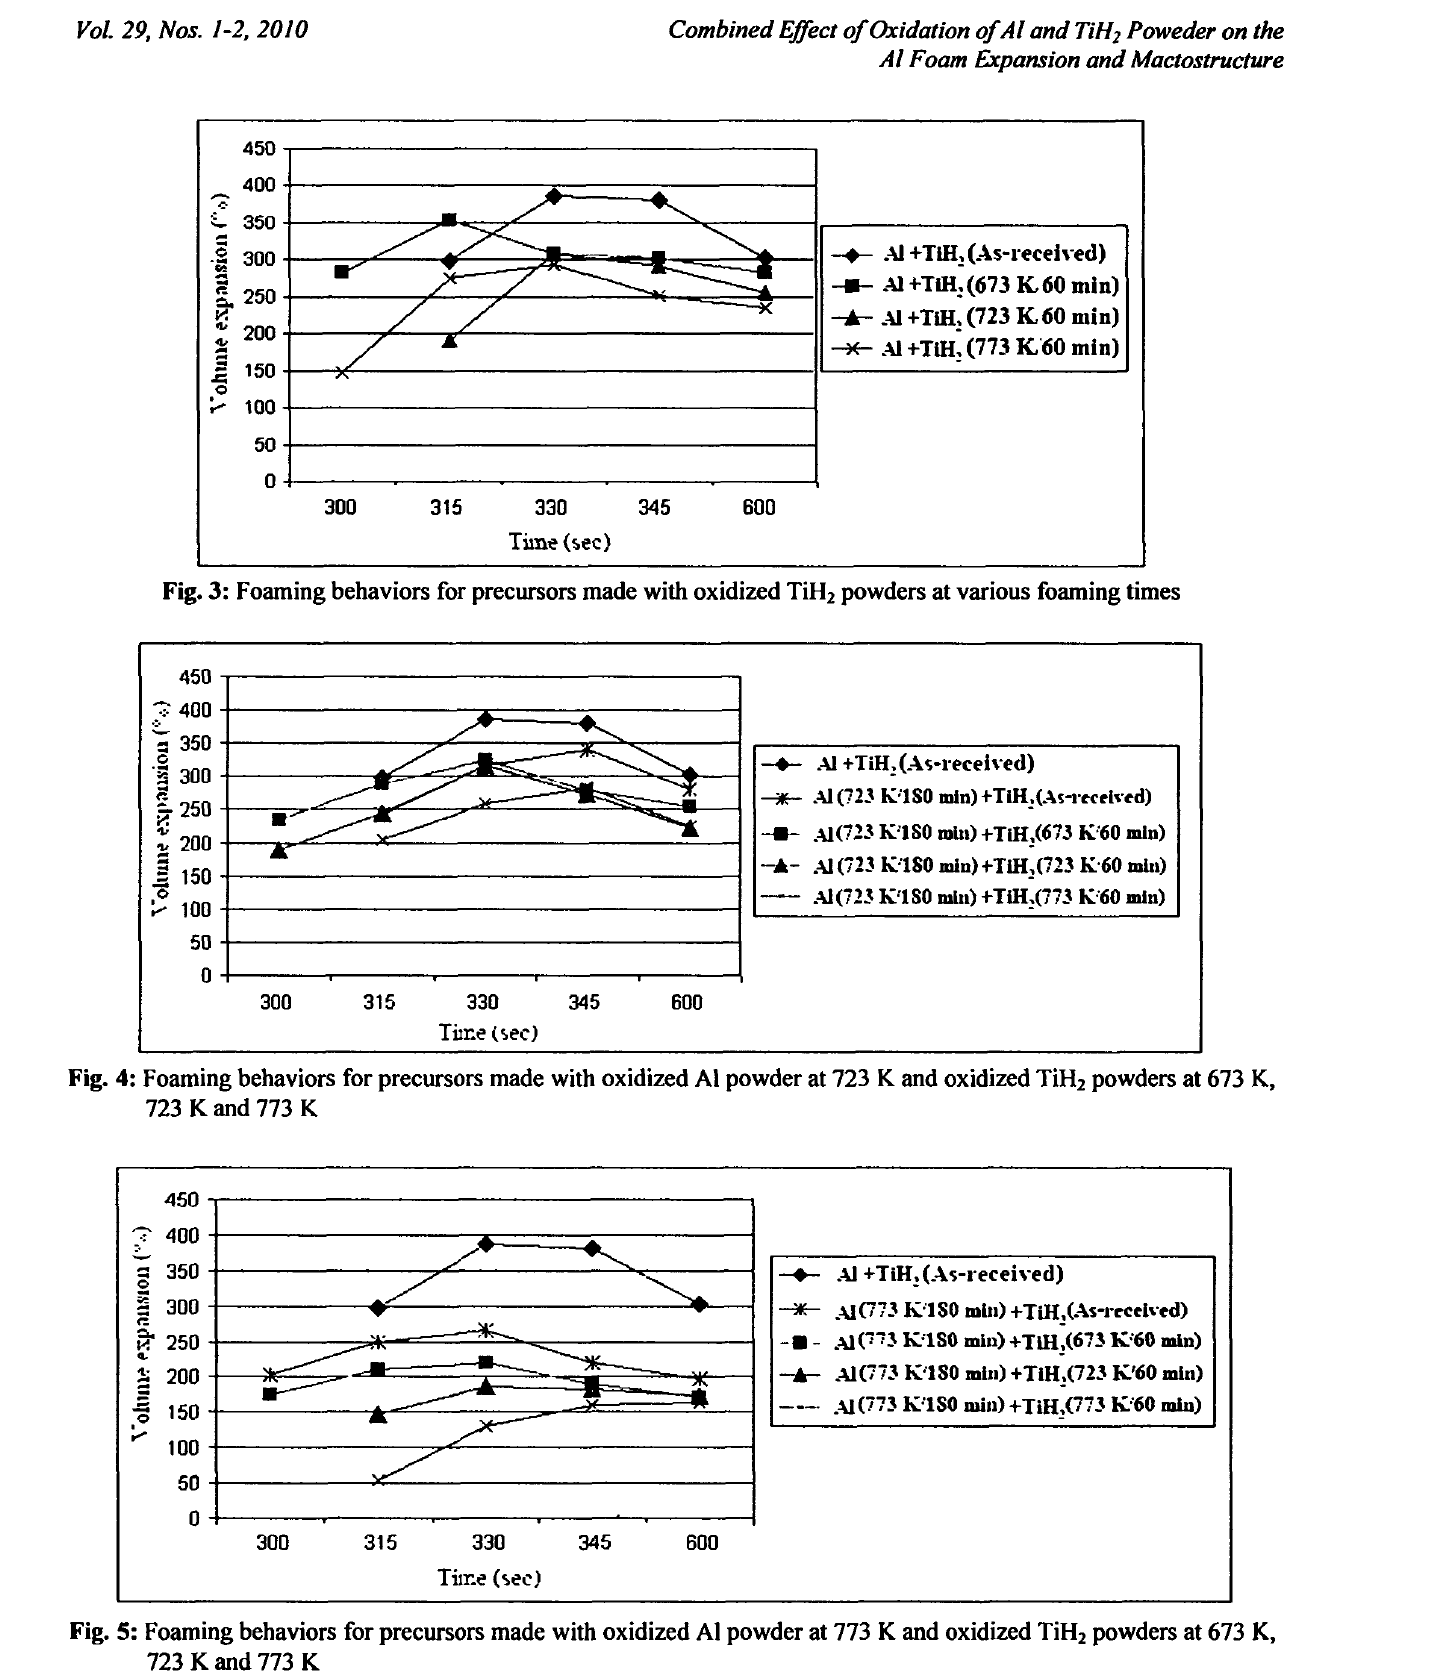
Fig. 5: Foaming behaviors for precursors made with oxidized Al powder at 773 K and oxidized TiH 723 K and 773